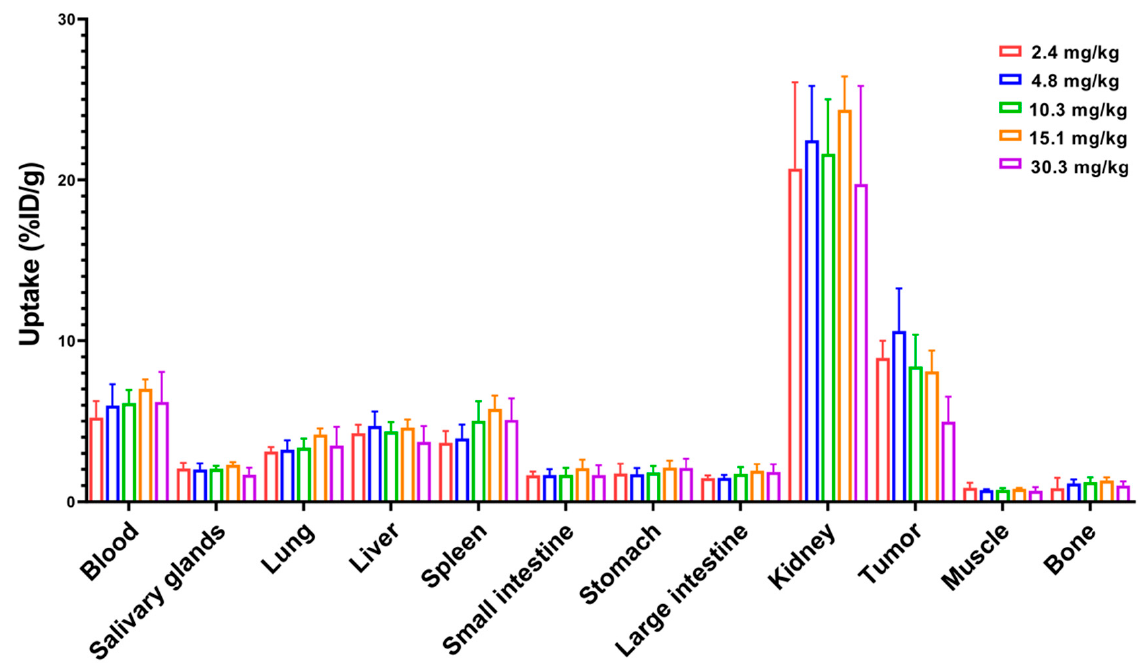
Figure 5. Dose escalation experiment where 99m Tc-labeled Z HER2:2891 -ABD-E 3 -mcDM1 was injected into female BALB/c nu/nu mice carrying SKOV3 xenografts. The radioactivity in each organ was measured 48 h p.i. and is expressed as per cent of injected dose per gram tissue (%ID/g), and presented as an average value from 3 to 5 animals ± 1 SD.